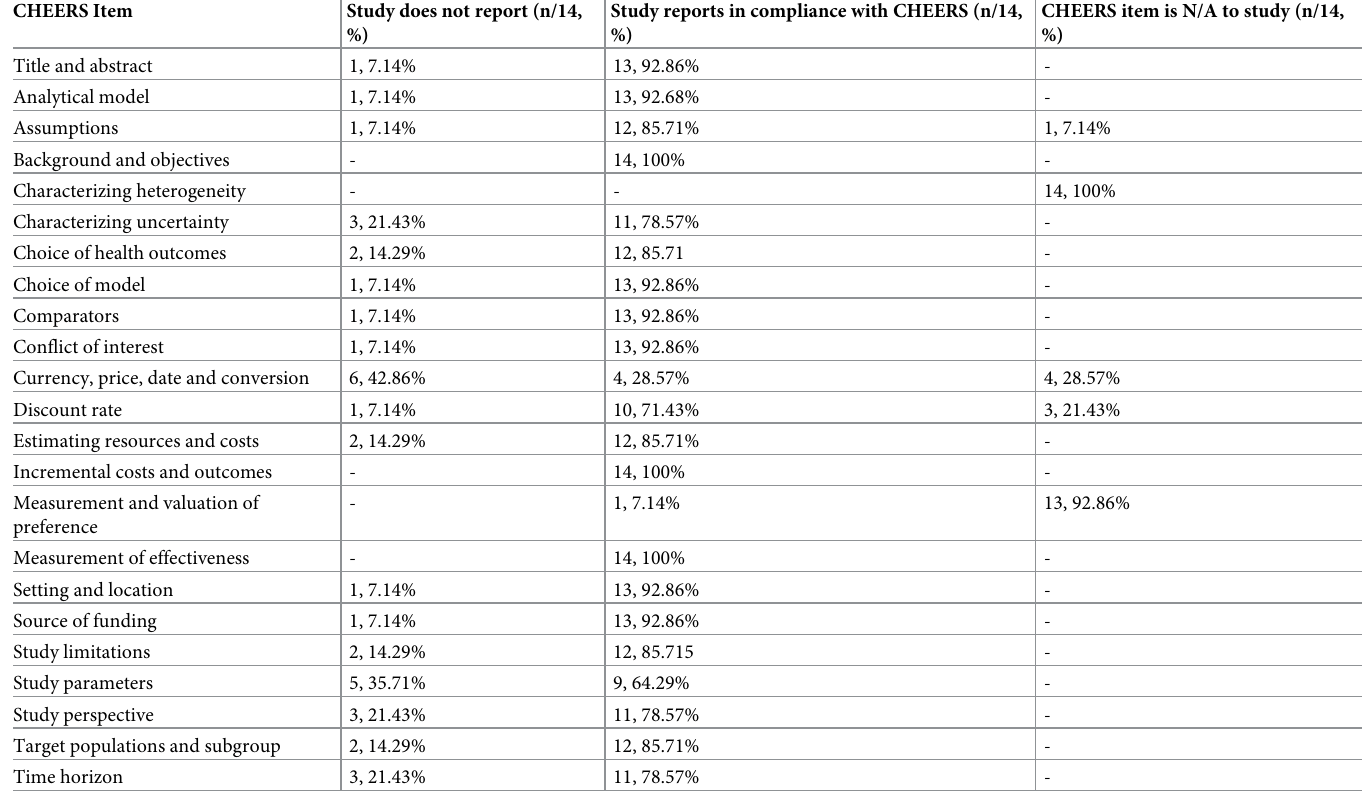
Table 5. Reporting on CHEERS